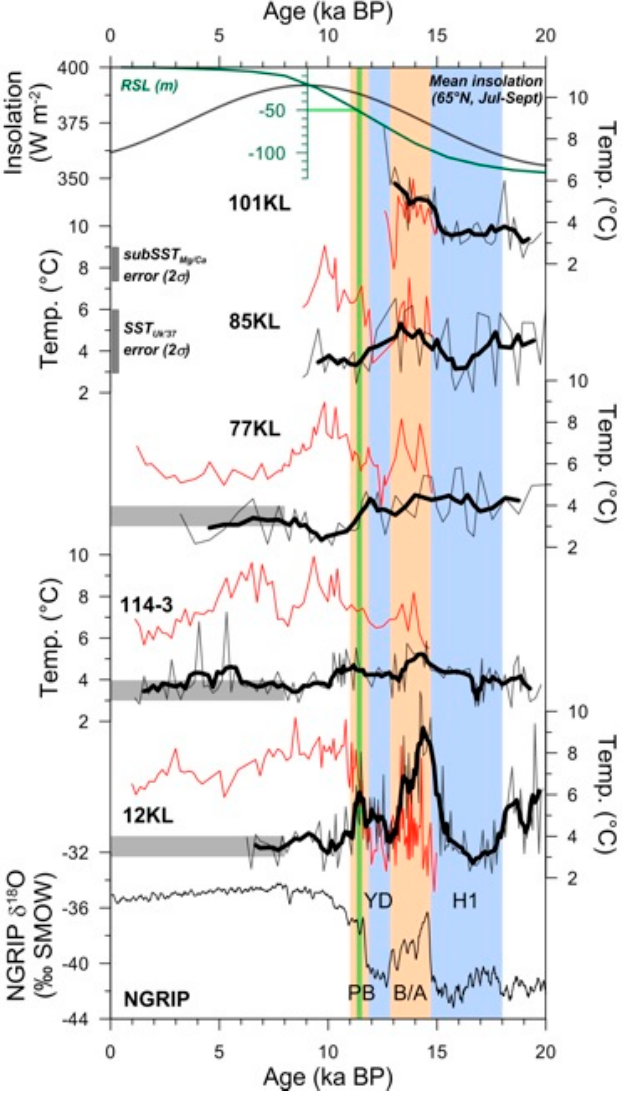
Figure 6. (left panel) Temperature reconstructions covering the last 20 ka form the Bering Sea, the Okhotsk Sea, and the subarctic North Pacific. Northern Greenland Ice Core (NGRIP) oxygen isotope record shown for reference [80]. The sea surface temperature (SST) Mg/Ca records (grey, moving averages in black) are compared to UK’37-based SST data (red, [81]. Shaded areas are averaged mid-Holocene (<8 ka BP) temperatures of 3–4 °C, corresponding to modern temperatures. Sea level curve after [82], vertical green line marks the 50 m sill depth for the Bering Strait. Bølling/Allerød (B/A), Preboreal (PB), Heinrich Stadial 1 (HS-1), and Younger Dryas (YD) marked by colored bars. Figure from Riethdorf et al., 2013 [30].